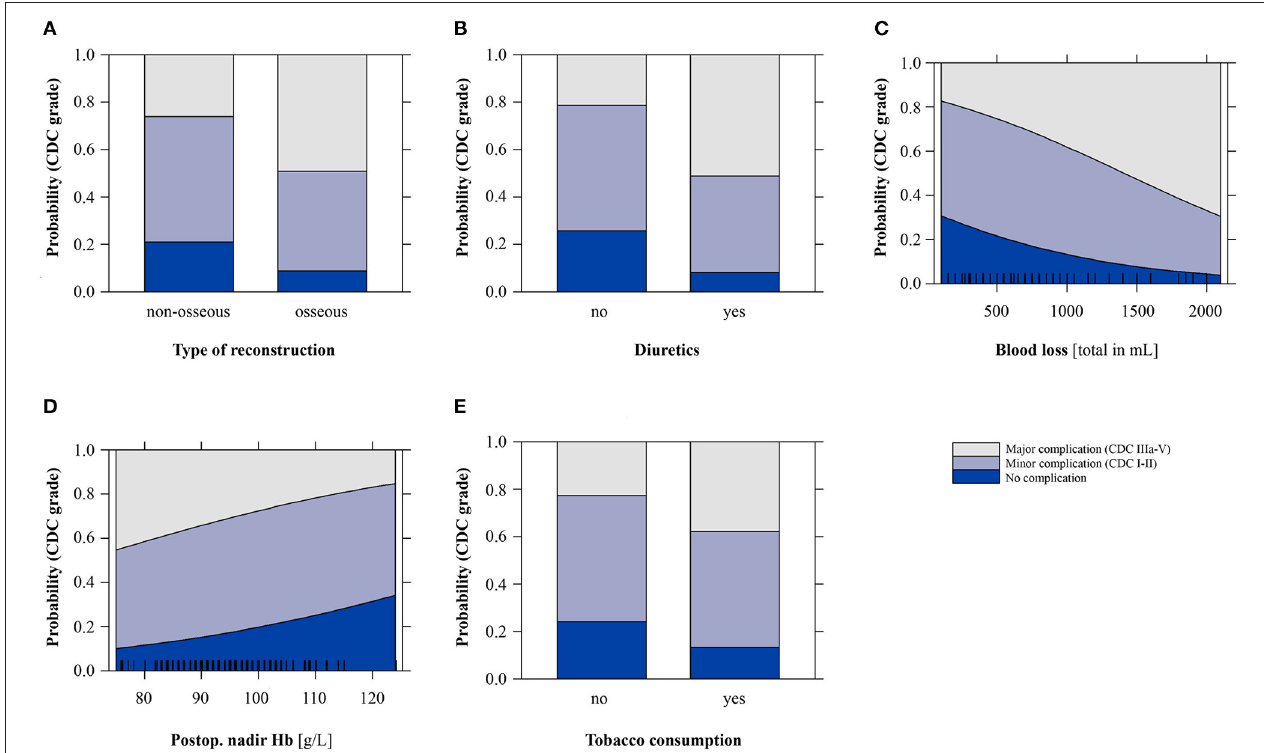
FIGURE 3 | Effect plots of the ordinal regression model for predicting the outcome “Clavien-Dindo classification grade” (CDC; minor CDC: I-II; major CDC: IIIa-V). g/L, grams per liter; Hb, hemoglobin; mL,